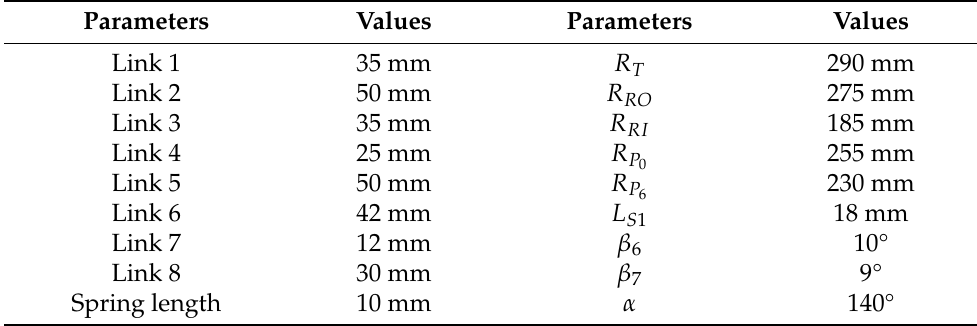
Table 1. Dimensions of the members of the anti-slip